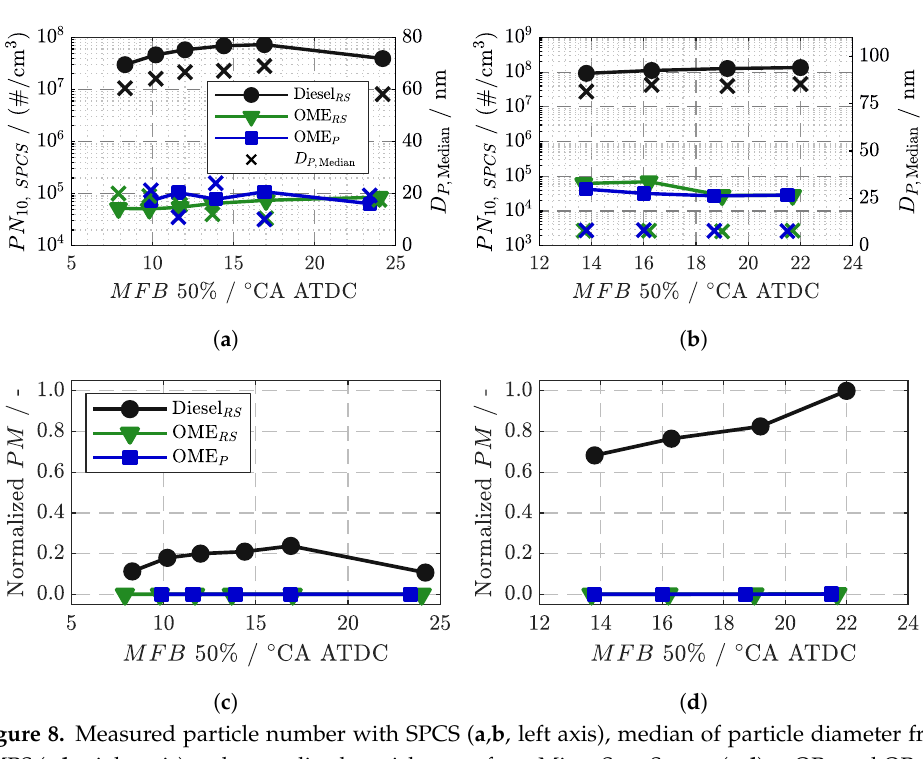
Figure 8. Measured particle number with SPCS ( a , b , left axis), median of particle diameter from SMPS ( a , b , right axis) and normalized particle mass from Micro Soot Sensor ( c , d ) at OP 1 and OP 2 for diesel and two different nozzles in OME